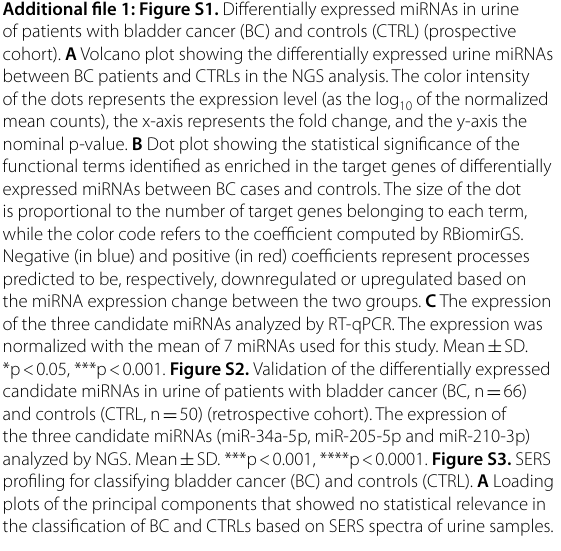
B The relationship between the number of principal components (x-axis) and the explained variance in the original dataset (y-axis) of BC cases versus CTRLs. The first 11 principal components explain 98.3% of the vari- ance in the original dataset. Figure S4. Urine liquid biopsy by combining miRNA and SERS profiling for classifying low- and high-grade bladder cancer (BC). A Representative H&E staining of low-grade (LG) versus high-grade (HG) BC patients. B Volcano plot of differentially expressed miRNAs by NGS analysis in the urine of LG and HG BC patients. The color intensity of the dots represents the expression level, the x-axis represents the fold change, and the y-axis the nominal p-value. C. Heat map of the differentially expressed miRNAs in urine between LG and HG BC patients. The color scale shows the log 10 of the normalized counts. D Normalized expression levels of miR-1246 for LG and HG BC measured by NGS. E Relative expression levels of miR-1246 in LG and HG BC measured by RT- qPCR. F Normalized expression levels of miR-1246 for LG and HG BC of the miRNA validation cohort measured by NGS. G The average SERS spectrum of urine from LG versus HG BC patients. H The distribution of score values for principal component (PC) PC5 and PC6 of patients with LG (red) versus HG BC (blue). I Receiver operating characteristic (ROC) curve for the classification of LG and HG BC achieved by naïve Bayes algorithm run on datasets consisting of the differentially expressed miRNA alone (miR- 1246), SERS data alone (first 11 PCs), or a combination of the two. J ROC curve for the classification of LG and HG BC achieved by logistic regression algorithm run on datasets consisting of the differentially expressed miRNA alone (miR-1246), SERS data alone (first 11 PCs), or a combination of the two. K The ROC curve for the classification of LG and HG BC achieved by random forest algorithm run on datasets consisting of the differently expressed miRNA alone (miR-1246), SERS data alone (first 11 PCs), or a combination of the two. Mean SD. ns not significant, **p < 0.01. ± = Figure S5. Urine liquid biopsy by combining miRNA and SERS profiling for classifying luminal and basal type bladder cancer (BC). A Representa- tive immunohistochemistry (IHC) staining for TP53 mutated samples (TP53 accumulating nuclear), diffuse nuclear staining for GATA3 (100% of the tumor cells), weak ER staining (17.5%), and complete, circumferential staining of cell membranes for Her2neu (100% of the tumor cells score = 3). B Volcano plot of differentially expressed miRNAs by NGS analysis in the urine of luminal and basal BC patients. The color intensity of the dots represents the expression levels, the x-axis represents the fold change, and the y-axis the nominal p-value. C Heat map of the differentially expressed miRNAs by NGS analysis in urine between luminal and basal BC. The color scale shows the log 10 of the normalized counts. D Normalized expression levels of miR-204-5p in luminal and basal type BC measured by NGS. E Relative expression levels of miR-615-3p, miR-185-5p, and miR-204-5p in luminal and basal type BC measured by RT-qPCR. The expression was normalized with the mean of 7 miRNAs used for this study. F The relation- ship between the number of principal components (x-axis) and the explained variance in the original dataset (y-axis) of luminal versus basal BC. The first 11 principal components explain around 98% of the variance